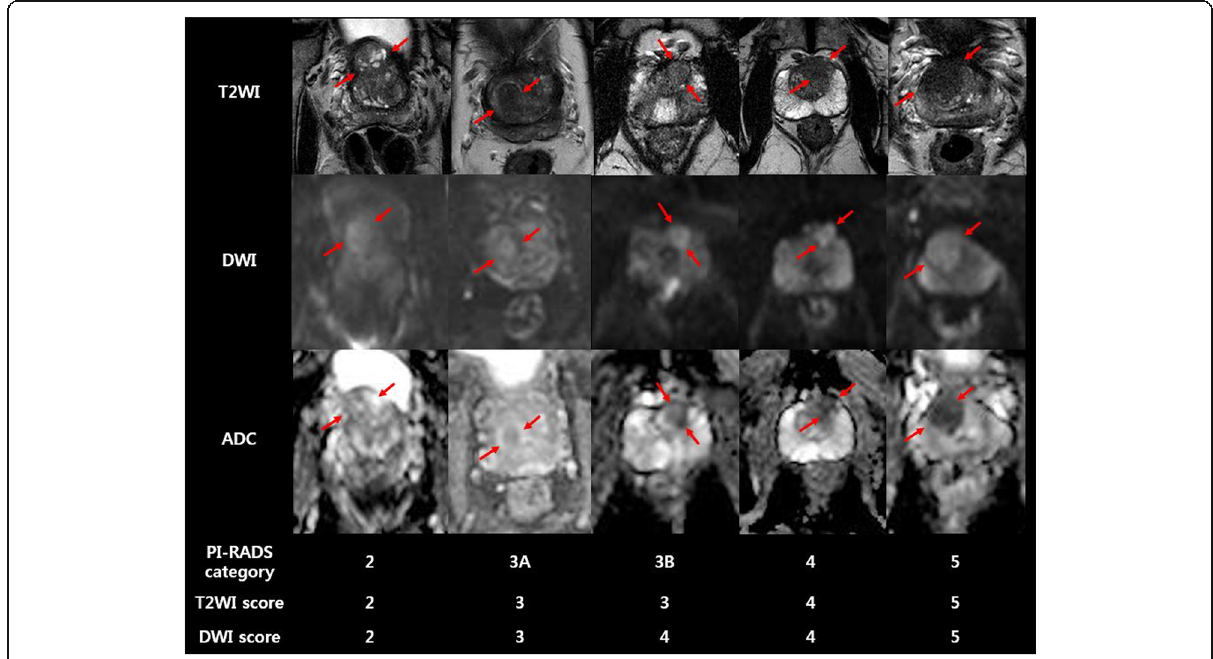
Fig. 2 Examples of transition zone prostate cancer for reader interpreted according to modified PI-RADS v2.1-B. a T2-weighted image (T2WI) showed 17-mm-sized encapsulated nodule with mild hyperintensity (T2WI score 2) in the right transition zone with linear diffusion restriction (DWI score 2). The lesion was categorized as 2 according to PI-RADS v2.1-B. b T2WI showed 12-mm-sized obscured marginated, heterogeneous nodule (T2WI score 3) in the rignt transition zone with mild diffusion restriction (DWI score 3), which was categorized as 3A according to PI-RADS v2.1-B. c T2WI showed 10-mm-sized obscured, heterogeneous nodule (T2WI score 3) in the left transition zone, with focal marked diffusion restriction (DWI score 4), suggesting category 3B according to PI-RADS v2.1-B. d T2WI showed 13-mm-sized non-circumscribed, homogeneous nodule (T2WI score 4) in the right transition zone, with marked diffusion restriction (DWI score 4). The lesion was categorized as PI-RADS 4. e T2WI showed 17mm sized homogeneous nodule with extracapsular extension in the right transition zone (T2WI score 5), with marked diffusion restriction (DWI score 5), suggesting PI-RADS category 5